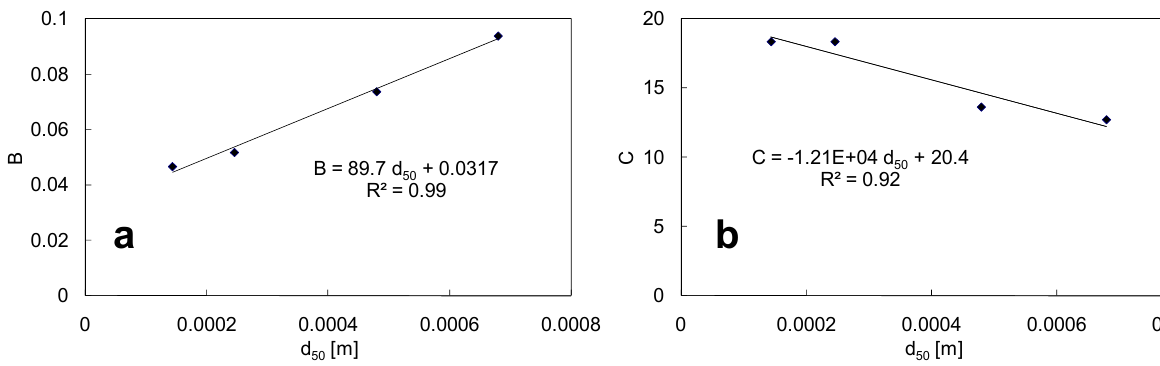
and B and (b) d 50